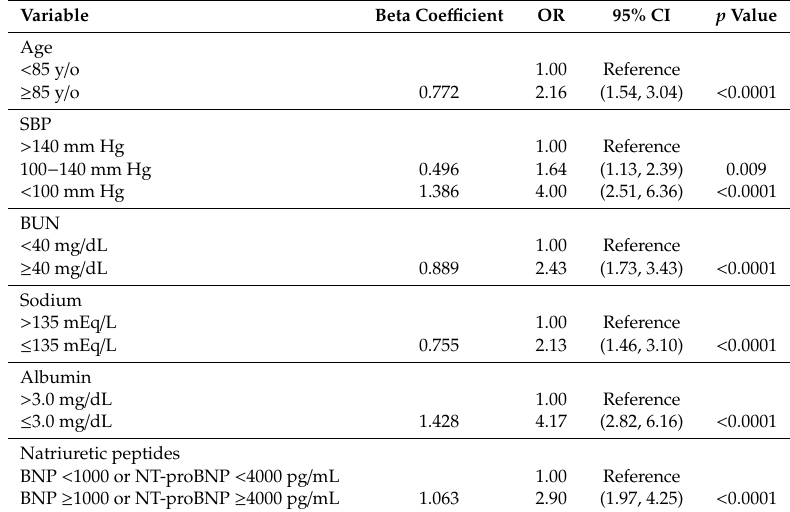
Table 3. Multivariable logistic regression model predicting in-hospital mortality with multiple imputation by chained equations (the number of imputations: